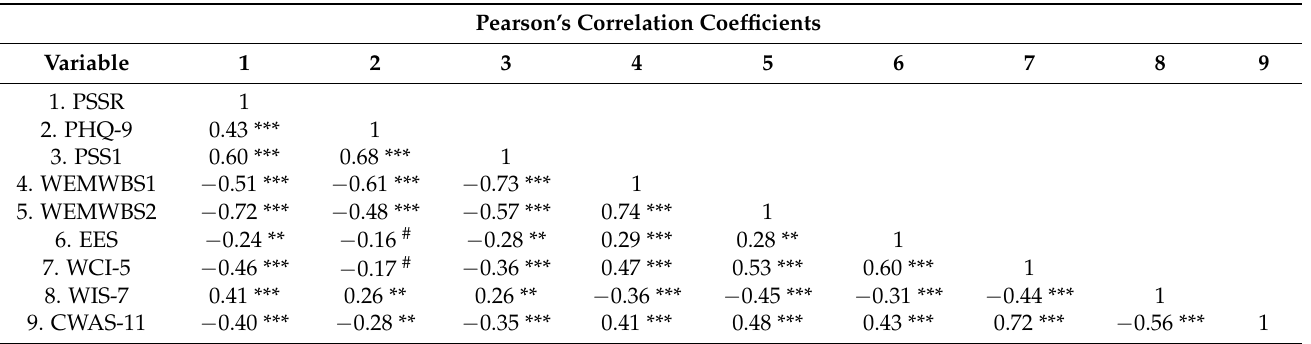
Table 2. Bivariate correlations and summary statistics for health and work-related surveys.